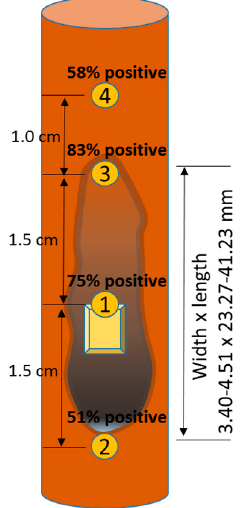
Figure 1. Sampling points (1–4) for PCR confirmation of H. fraxineus pathogen in the seedlings. Point 1 refers to the inoculation place; points 2 and 3 were 1.5 cm below and above sampling point 1, respectively; point 4 was 1 cm and 2.5 cm above points 3 and 1, respectively.